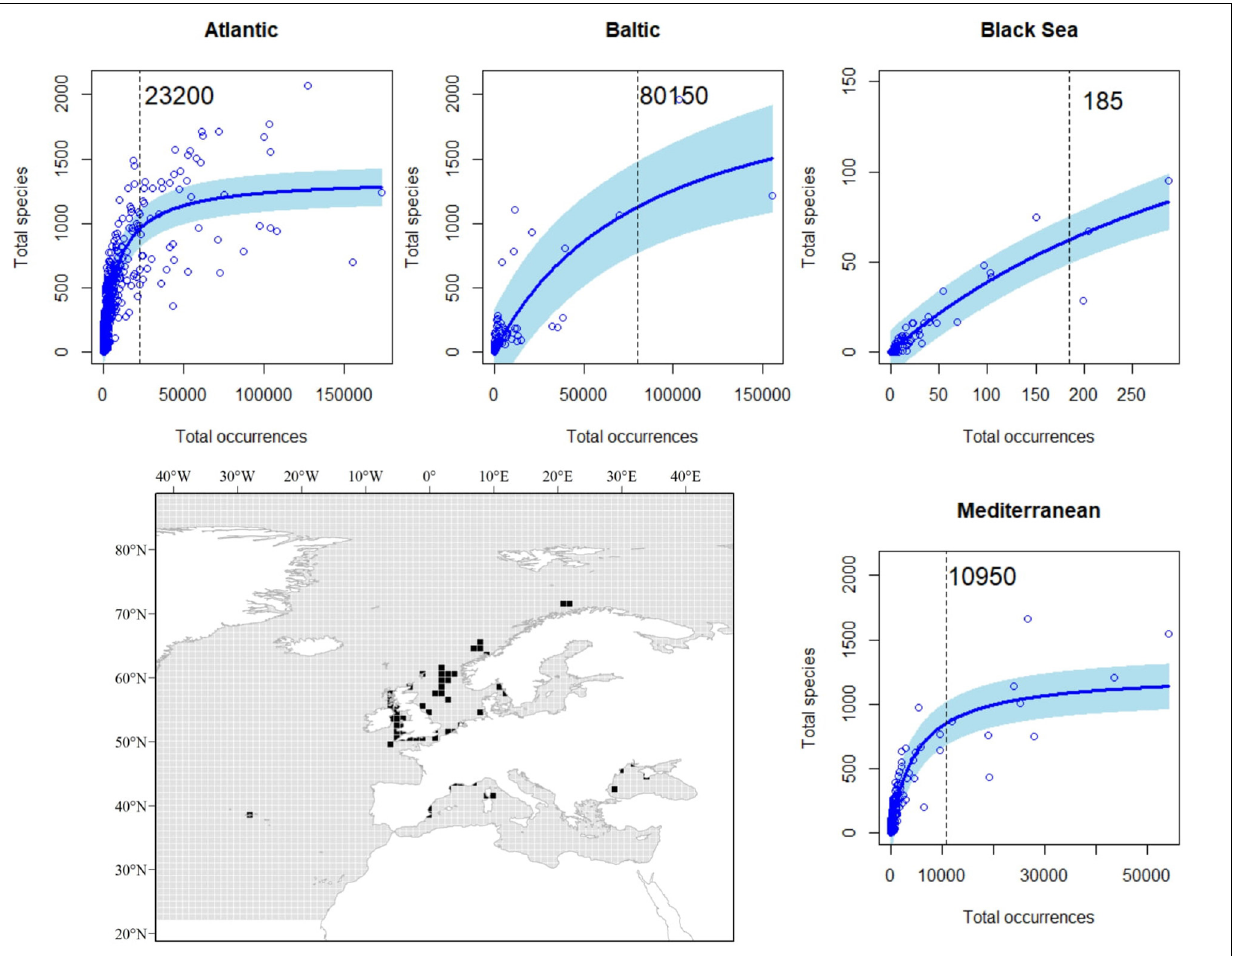
FIGURE 3 | Relationship between the total number of occurrences and the total number of species per cell in a 1 ◦ × 1 ◦ grid map; basin-specific thresholds (vertical dashed lines) and the spatial representations of those areas (black) with an adequate sampling effort to achieve a good representation of species